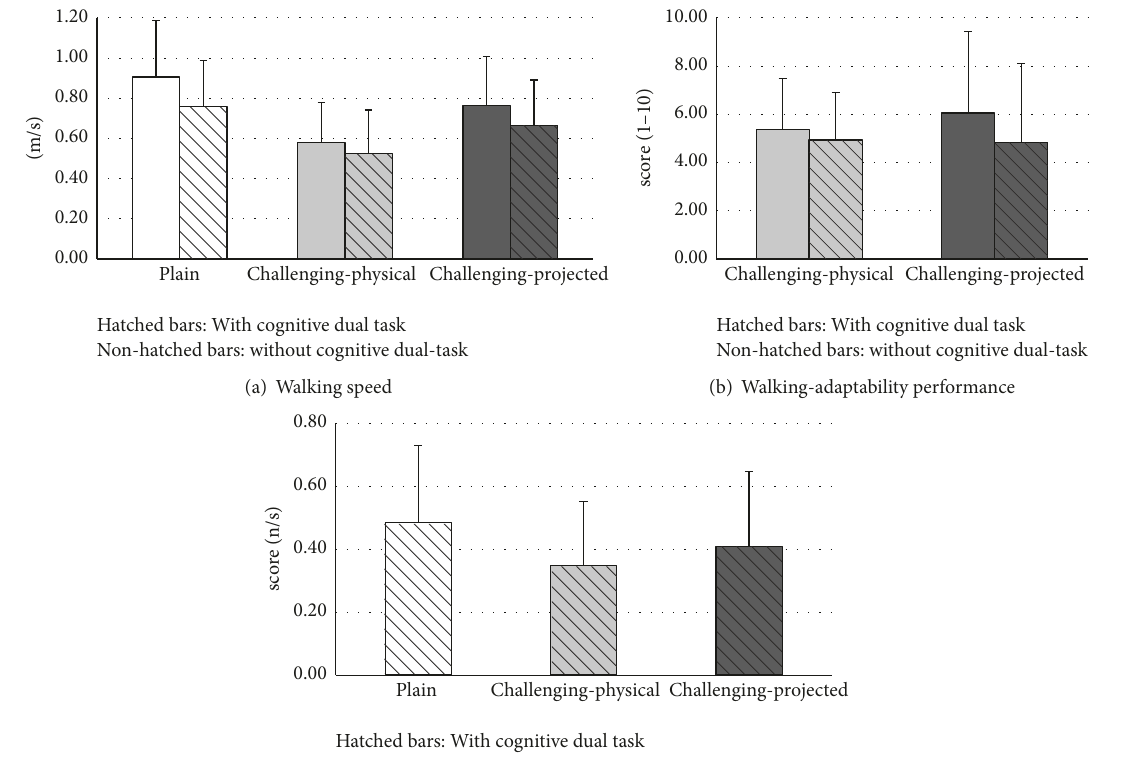
Figure 3: Representation of walking speed (a) for the six walking conditions (plain, challenging-physical, and challenging-projected, all with and without cognitive task), walking-adaptability performance score (b) for the two challenging walking environment conditions (challenging-physical and challenging-projected, with and without cognitive task), and cognitive-task performance score (c) for the three walking environments (plain, challenging-physical, and challenging-projected). Error bars represent the standard